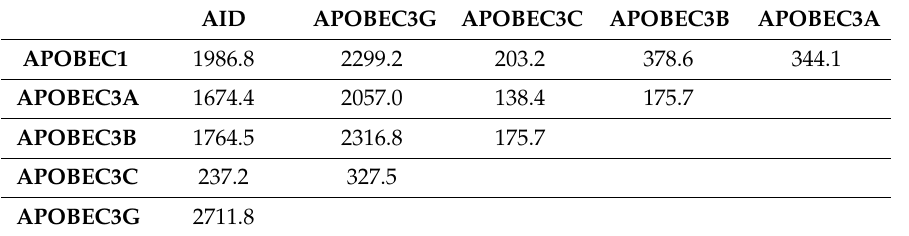
Figure 1. Information content and derived consensus sequences of the DNA context of mutations induced by AID/APOBEC deaminases in yeast genomes (frequencies of nucleotides were used as input). ( A ) APOBEC1, ( B ) APOBEC3A, ( C ) APOBEC3C, ( D ) APOBEC3B, ( E ) APOBEC3G, and ( F ) AID. Position 6 is the position of the somatic mutations. AID/APOBEC weight matrices are shown in Supplementary Figure S1. Table 1. Pairwise differences between the DNA context (position-specific nucleotide frequencies across ± 5 surrounding bases) of the studied AID/APOBEC